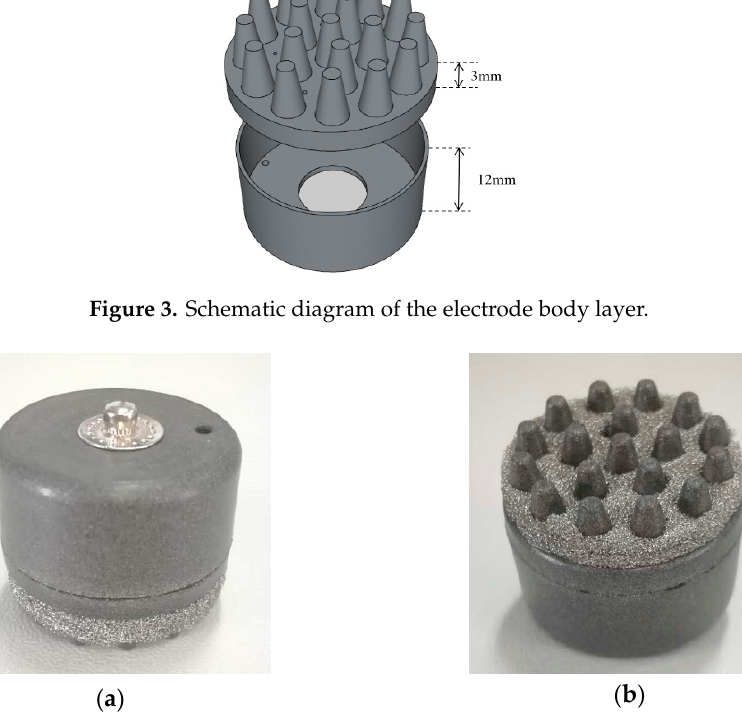
Figure 4. The flexible multi-layer semi-dry electrode: ( a ) top view of the electrode; ( b ) bottom view of the electrode.